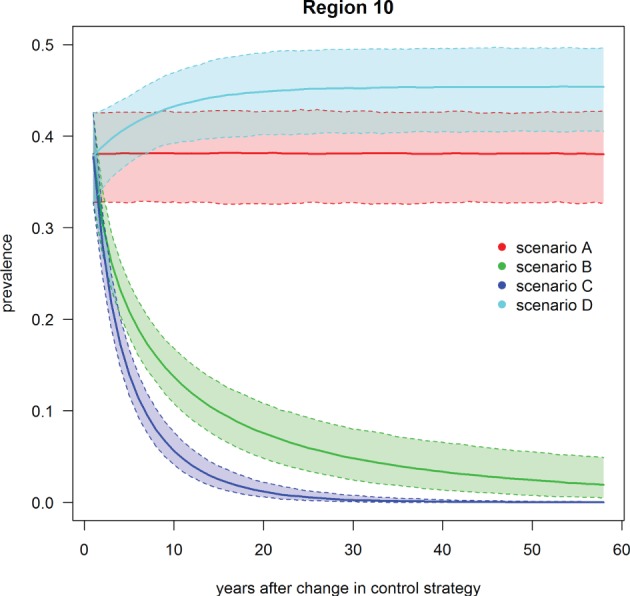
Trend of footrot prevalence for the four different scenarios A–D for region 10 (example for a region without mandatory control program). Lower dashed line = 2.5‰, upper dashed line = 97.5‰, solid line = median out of 1,000 simulations.